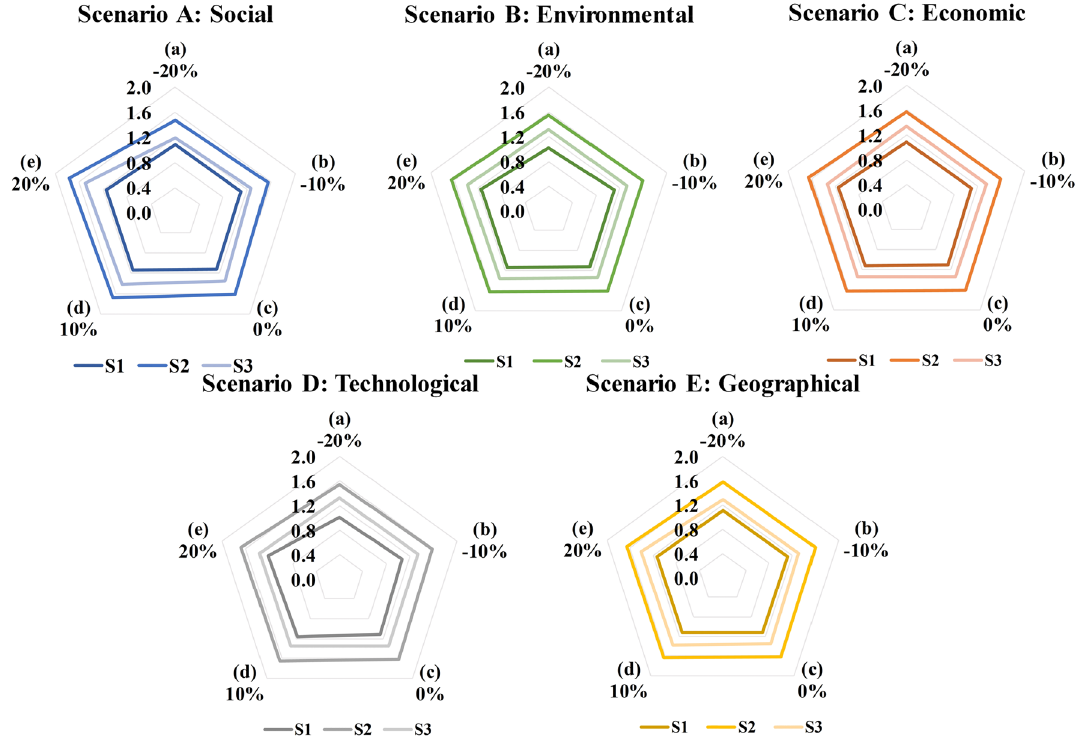
Figure 8. The sensitivity analysis results for scenarios A to